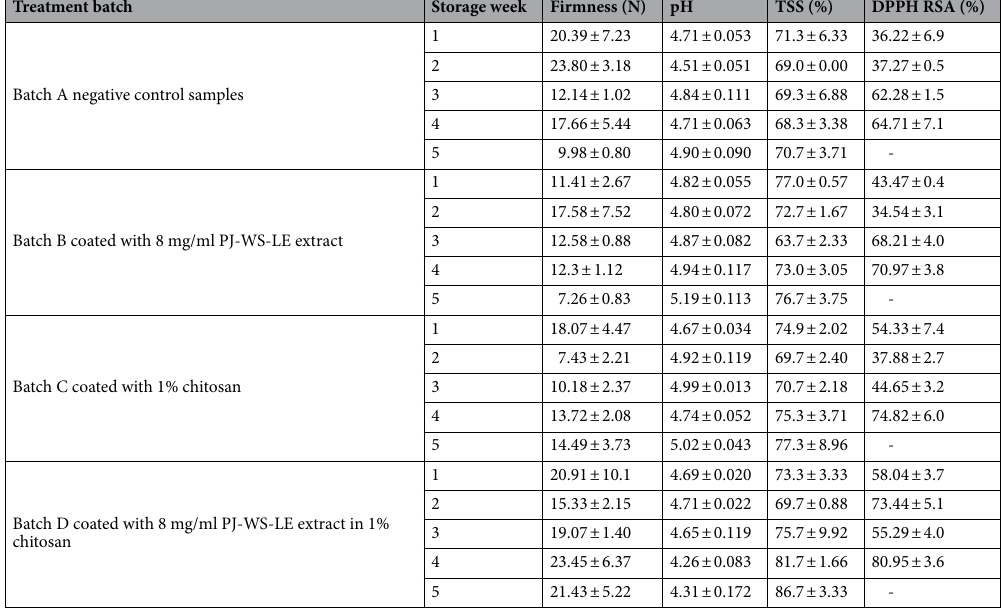
Table 3. Average firmness, pH, TSS and DPPH radical scavenging activity ± SE of mango samples exposed to different treatments (A: negative control non-treated fruit; B: PJ-WS-LE extract at 8 g L −1 was used to treat the fruit; C: 1% chitosan was used to treat the fruit; D: 8 g L −1 PJ-WS-LE extract embedded in 1% chitosan was used to treat the fruit) throughout 5